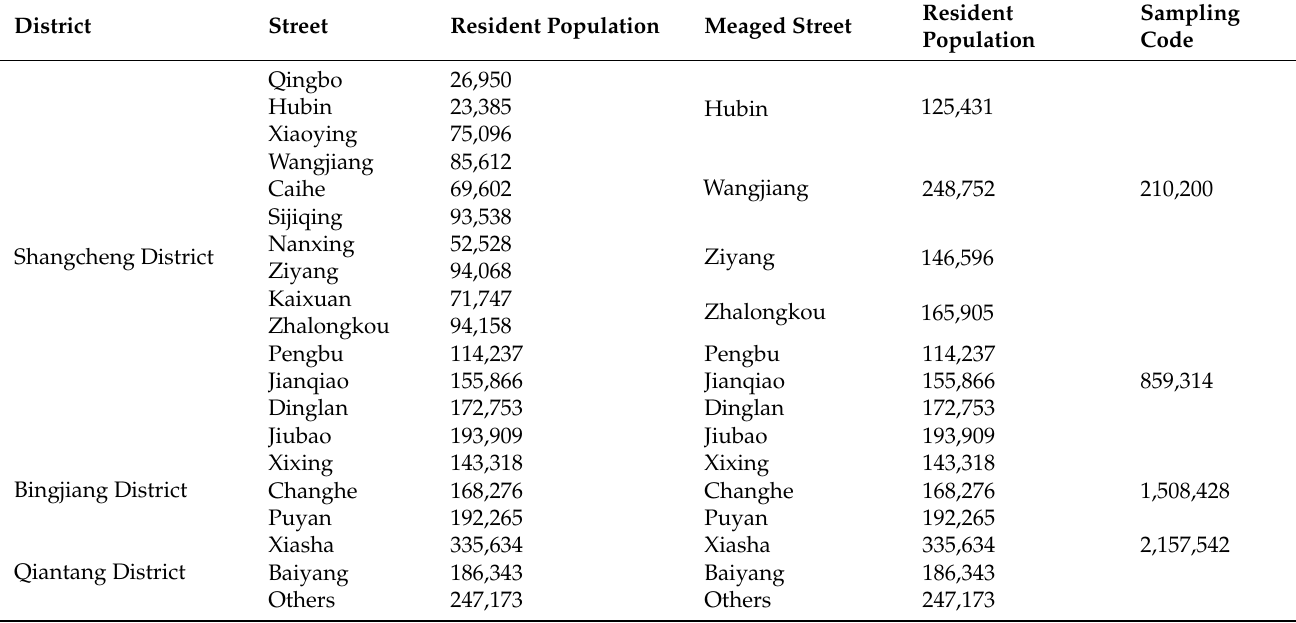
Table 1. Street Sampling